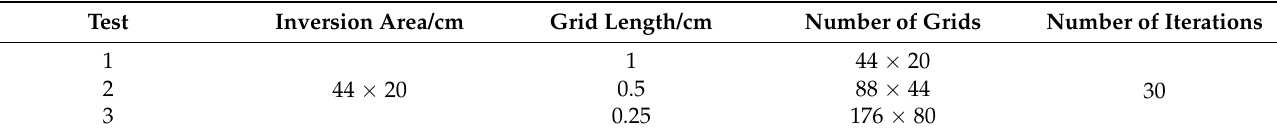
Table 1. Setup of 3 checkerboard tests.